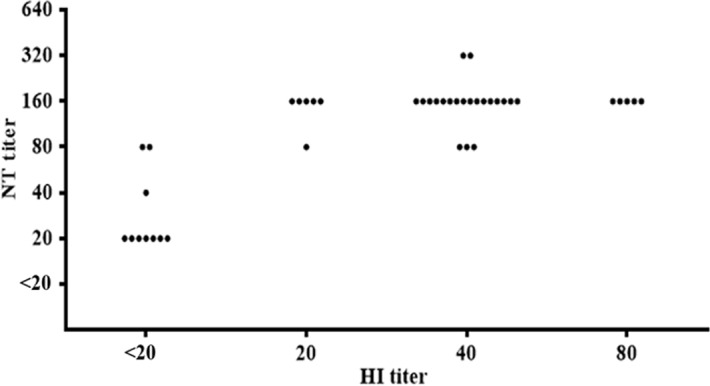
The correlation between HI and NT antibody titers to H1N1pdm virus in elephant sera.The figure displays 10 serum samples with HI titer <20, and 32 samples with HI titer ≥20.